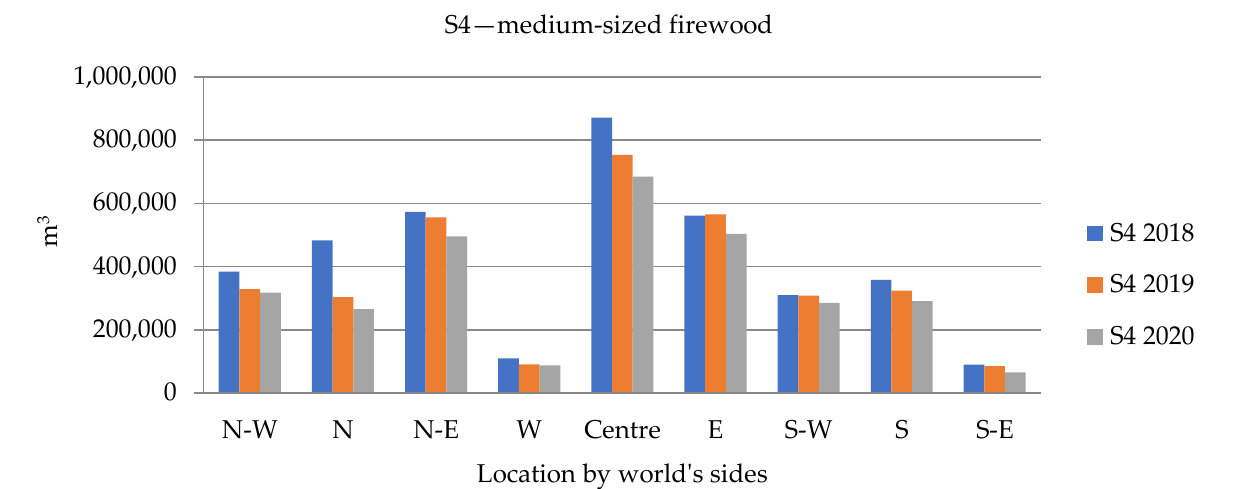
Figure 9. The amount of S4 firewood harvested in Poland between 2018 and 2020. Own elaboration based on the available data.